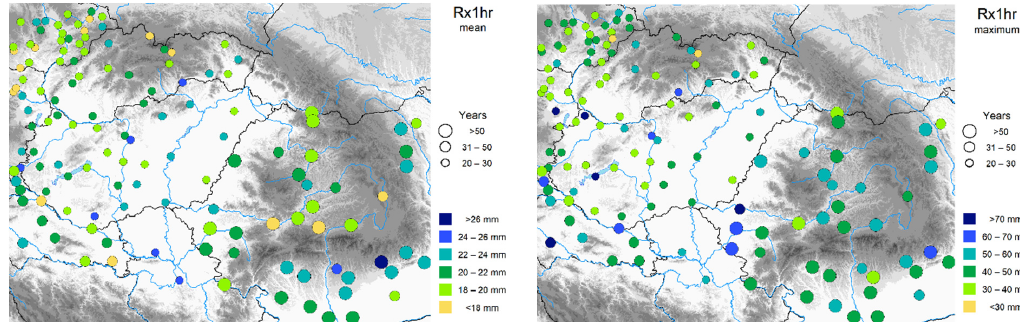
Figure 3. Annual average of 1-h maxima (Rx1hr) ( left ) and the maximum 1-h precipitation ( right ). The size of the markers represents the lengths of the available data series, whereas different colours present the range of values.